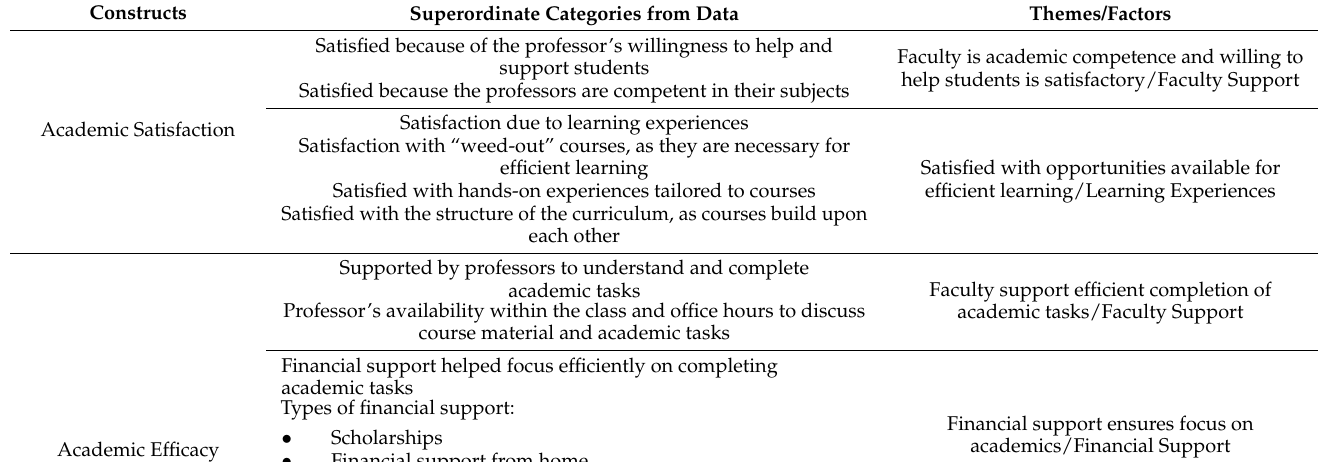
Table 2. Constructs, superordinate categories, themes, and their corresponding conceptualized